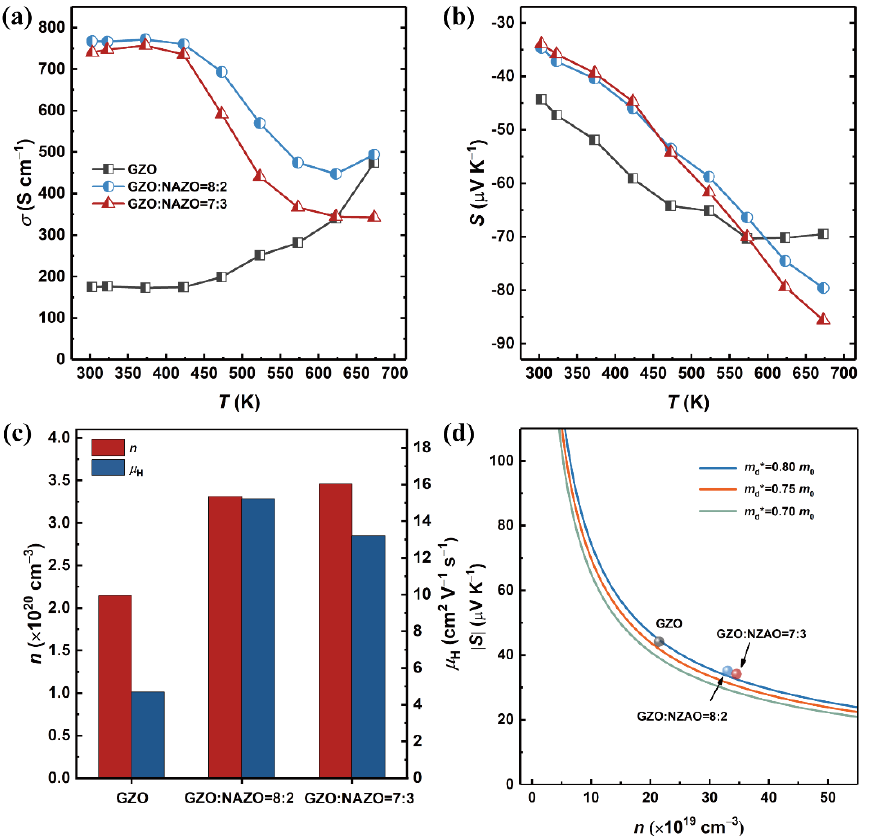
Figure 3. Electrical properties: ( a ) temperature-dependent electrical conductivity ( σ ); ( b ) temperature-dependent Seebeck coefficient ( S ); ( c ) room temperature Hall measurement results, including carrier concentration ( n ) and Hall mobility ( μ H ); ( d ) calculated room-temperature Pisarenko plots showing correlations among carrier concentration ( n ), Seebeck coefficient ( S ) and DOS effective mass ( m d* ) of samples. Table 1. Electrical transport properties of GZO thin film and GZO/NAZO thin films.